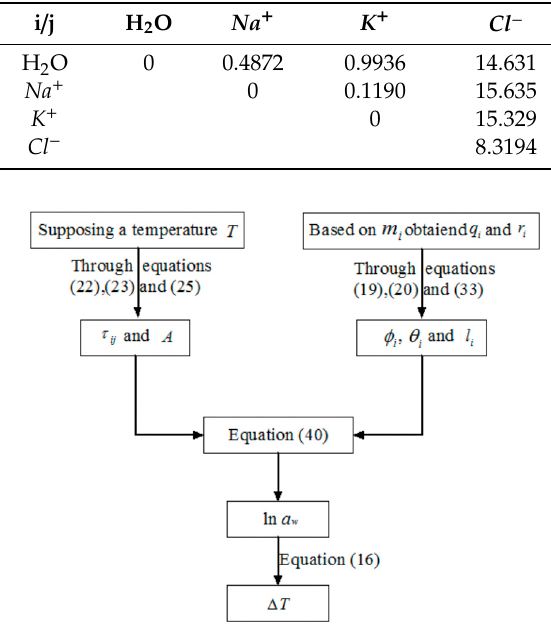
Table 4. Interaction parameters u t